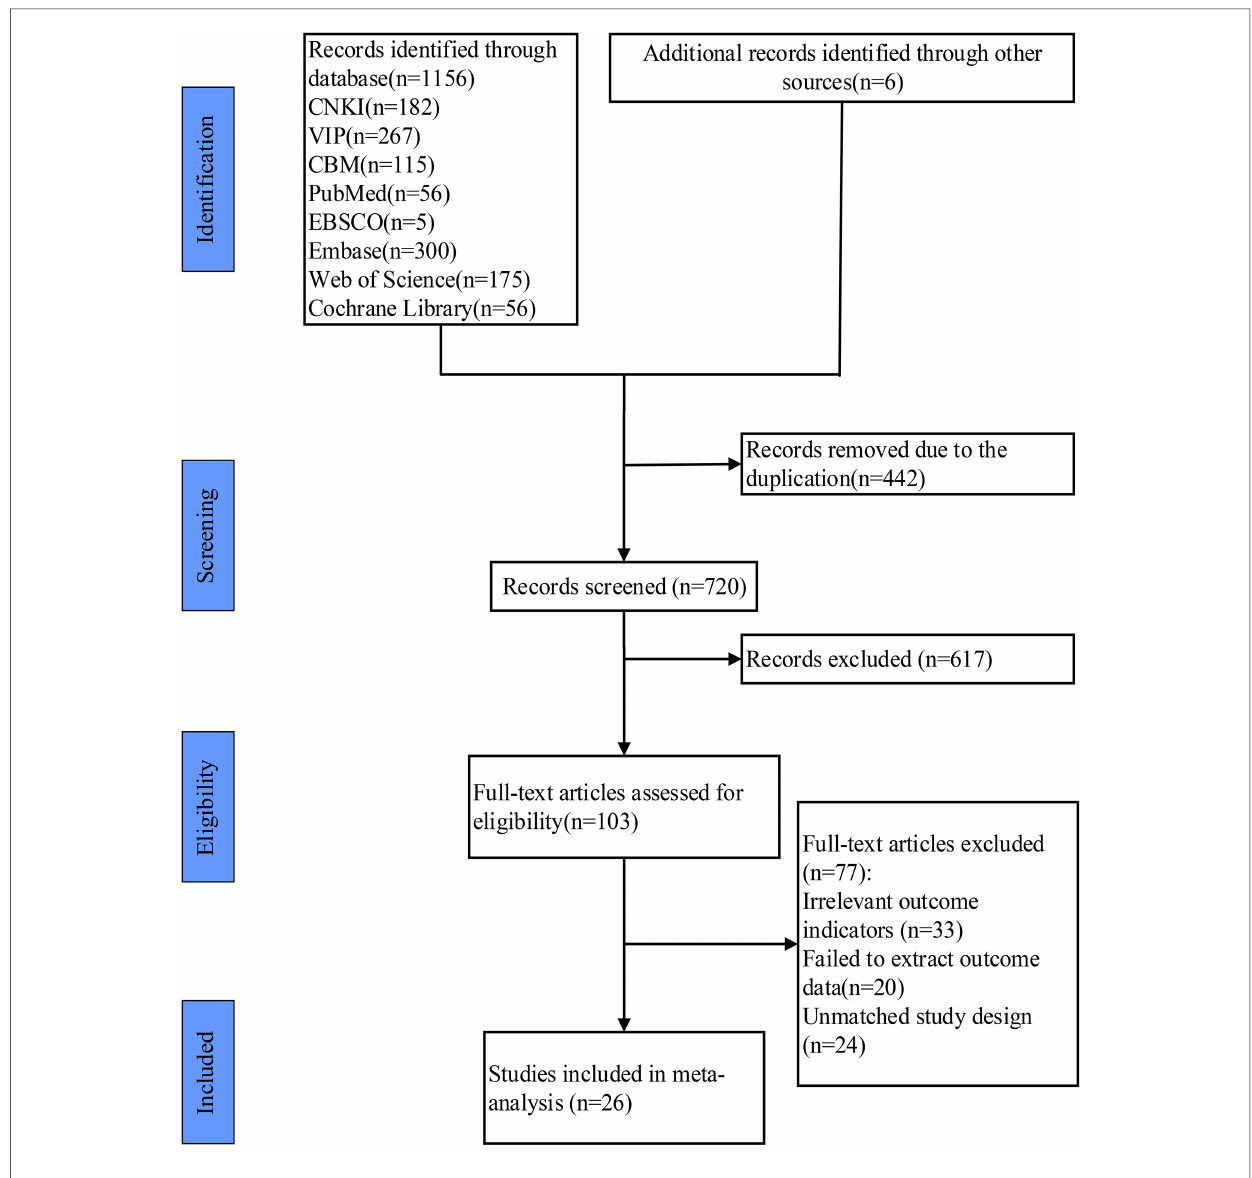
FIGURE 1 Study selection represented by PRISMA fl